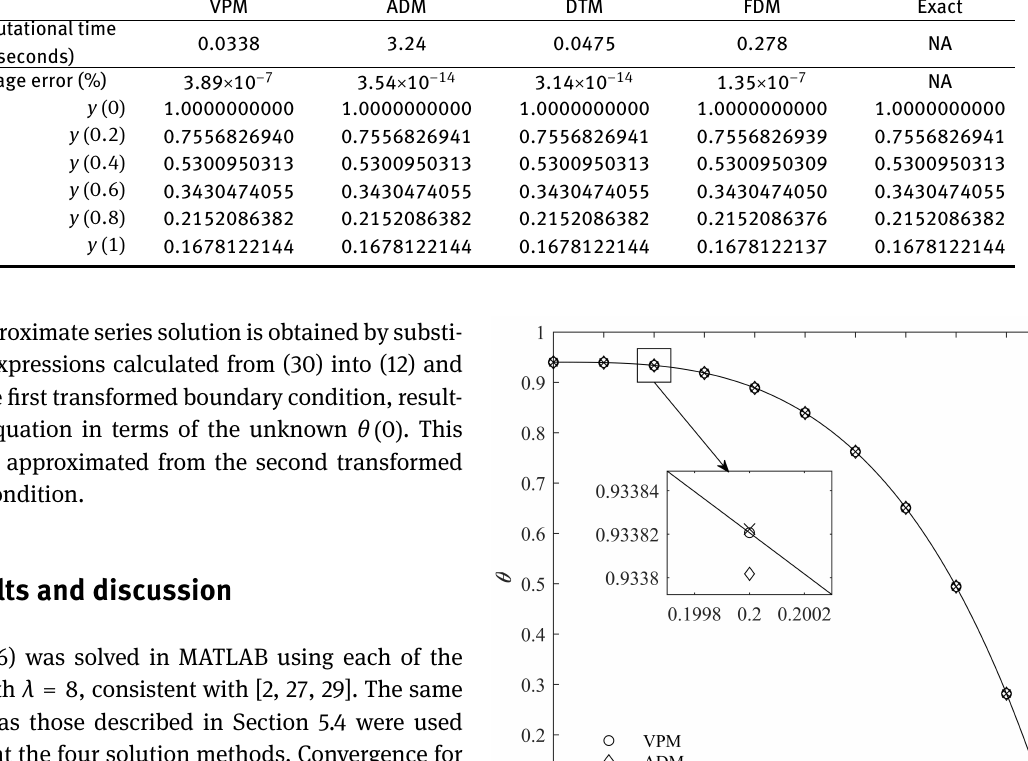
where θ is the approximate solution to (26) after n iter- n ations. The average error remainder function over the in- terval 0 ≤ s ≤ 1 at different values of n is a measure of the accuracy of the approximate solution as well as the rate of convergence. Figure 3 compares the average error remainder function as a function of iteration for the VPM, ADM, and DTM methods. Finite difference methods were employed to approximate θ ′′ in (32). The accuracy and rate n of convergence for VPM is comparable to that of DTM while ADM has better accuracy and